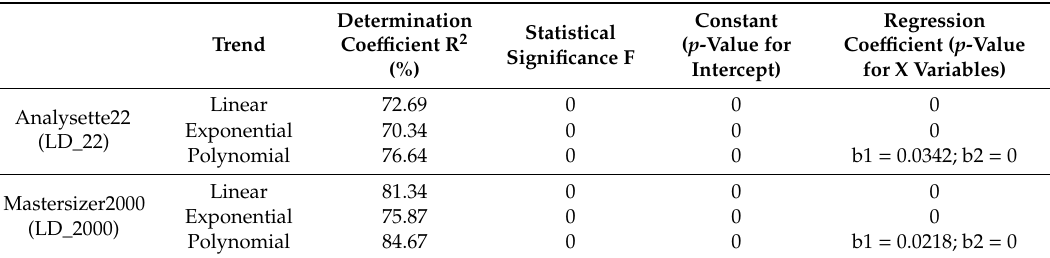
Table 2. Statistical verification of the regression models with the highest determination coe ffi cient, R 2 (n = 271).